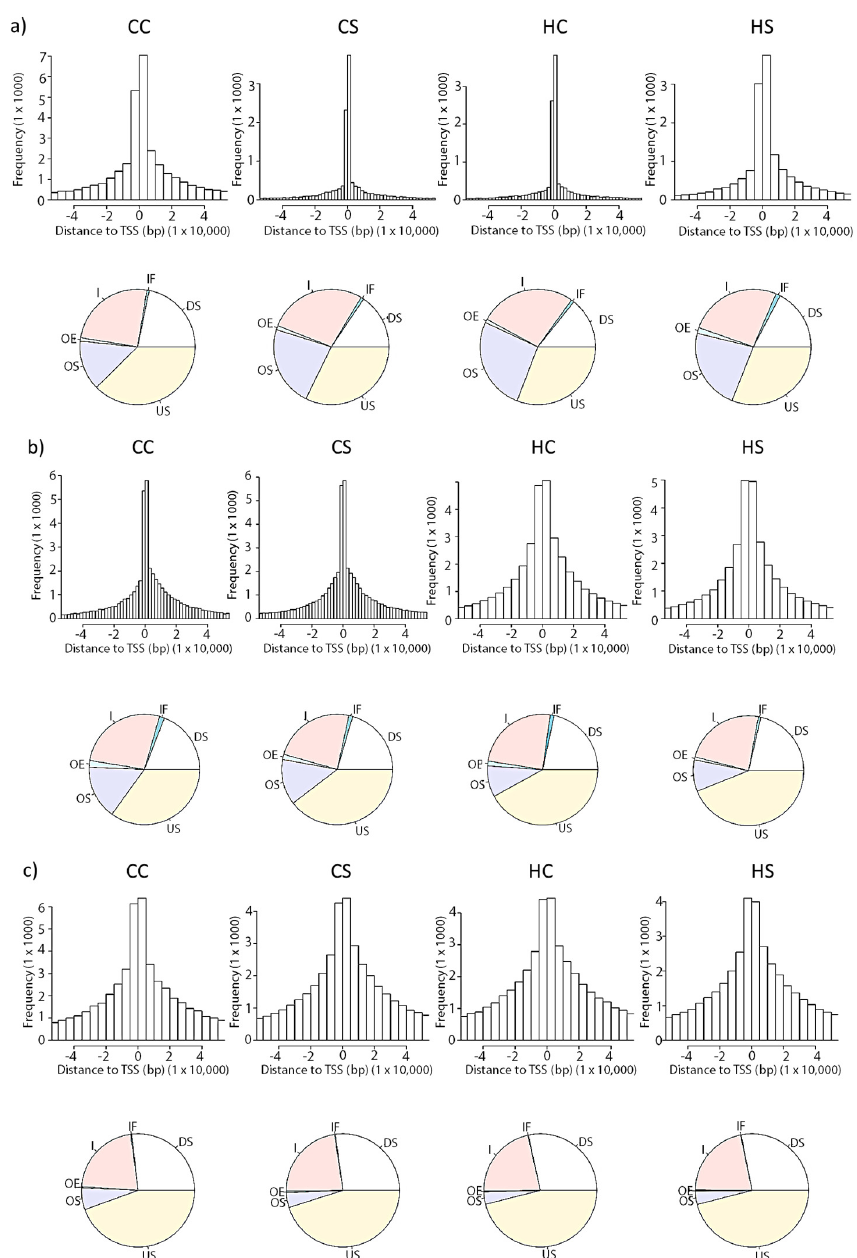
Figure A3. Genic distributions of differential histone marks. ( a ) H3Ac, ( b ) H3K4me3, and ( c ) H3K27me3 in four diet groups around the TSS in four diet groups are plotted. Distances to the nearest TSS for peaks identified and plotted in pie charts. CC, controls; CS, diabetes exposed; HC, HF-diet-exposed; HS, diet and diabetes exposed or combination exposed; TSS: transcription start site; US: upstream; DS: downstream; IF: include feature; I: inside; OE: overlap end; OS: overlap start.